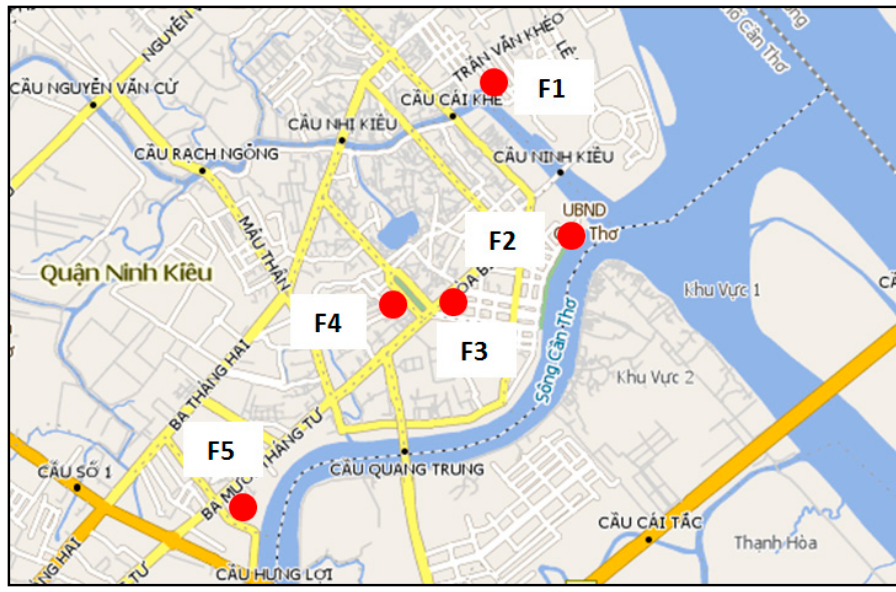
Figure 1. Locations of flooded sampling sites in Can Tho City.